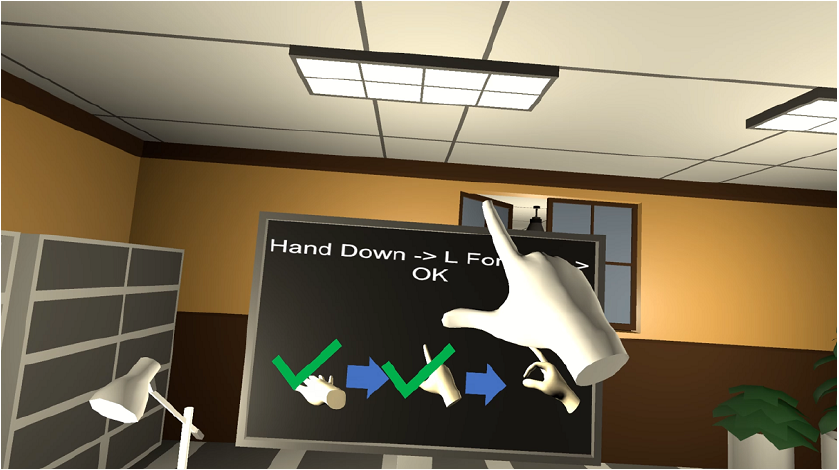
Figure 9. Experiment part two. A gesture set is displayed to the participant to be imitated. The aim is to test whether gestures can be concatenated easily and therefore allow more complex